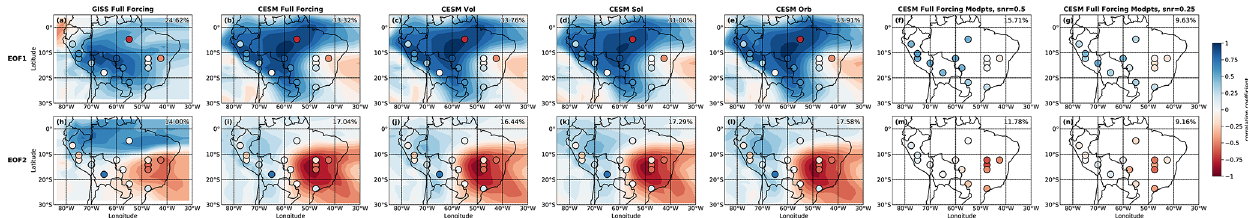
Figure 3. Comparison of model-derived modes (shading) overlaid with proxy-derived modes (circles) of isotopic variability. Color shading indicates the correlation of the EOF loadings with the corresponding PC time series. Models plotted are (a) EOF1 from the GISS full-forcing experiment, (b) as in (a) but for the iCESM full-forcing experiment, (c) as in (a) but for the iCESM volcanic forcing experiment, (d) as in (a) but for the iCESM solar irradiance experiment, (e) as in (a) but for the iCESM orbital forcing experiment, (f) iCESM PPE EOF1with signal-to-noise ratio = 0 . 5, and (g) as in (f) but for signal-to-noise ratio = 0 . 25. (h)–(n) as in (a)–(e) but for EOF2.